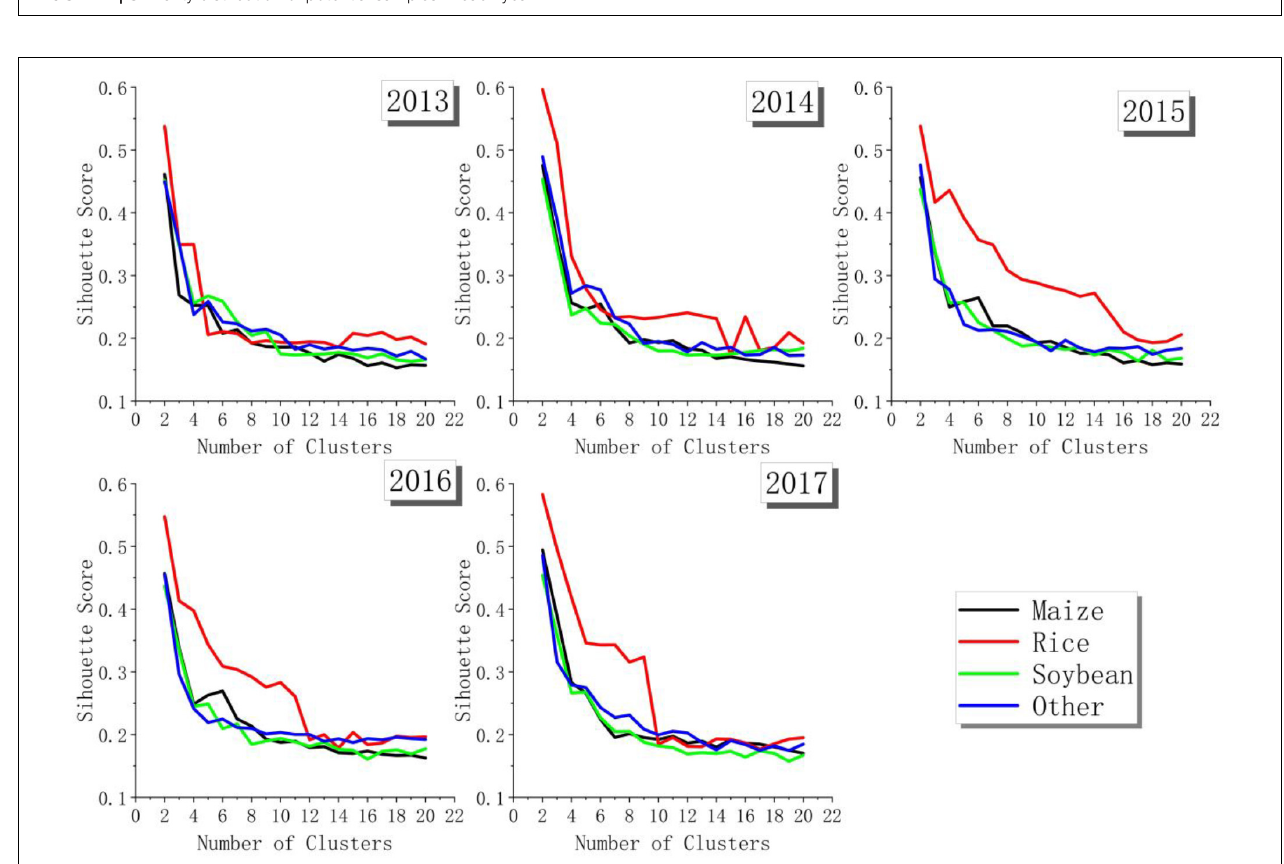
FIGURE 8 | Score of silhouette